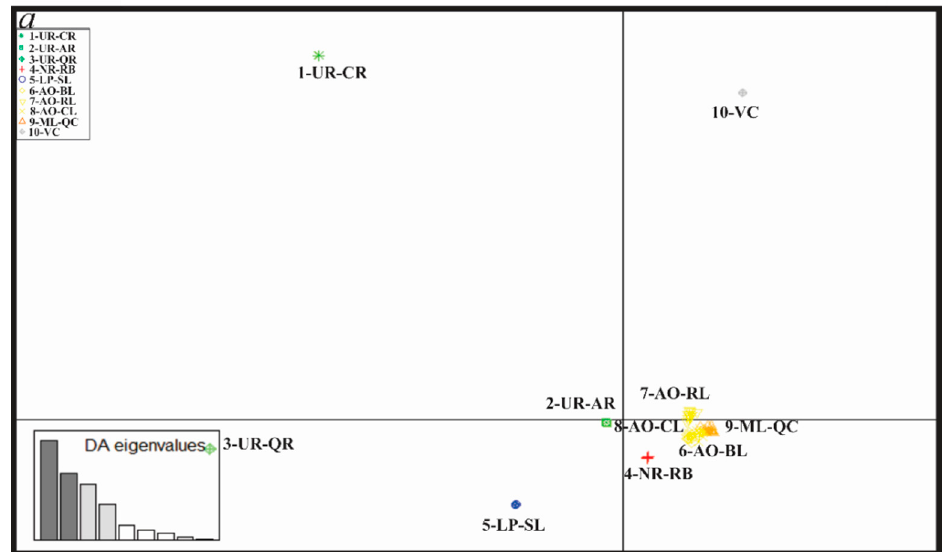
Table 3. Genetic diversity of Rhamdia quelen locality samples based on RAD-seq genotypes. Locality N Na H E F